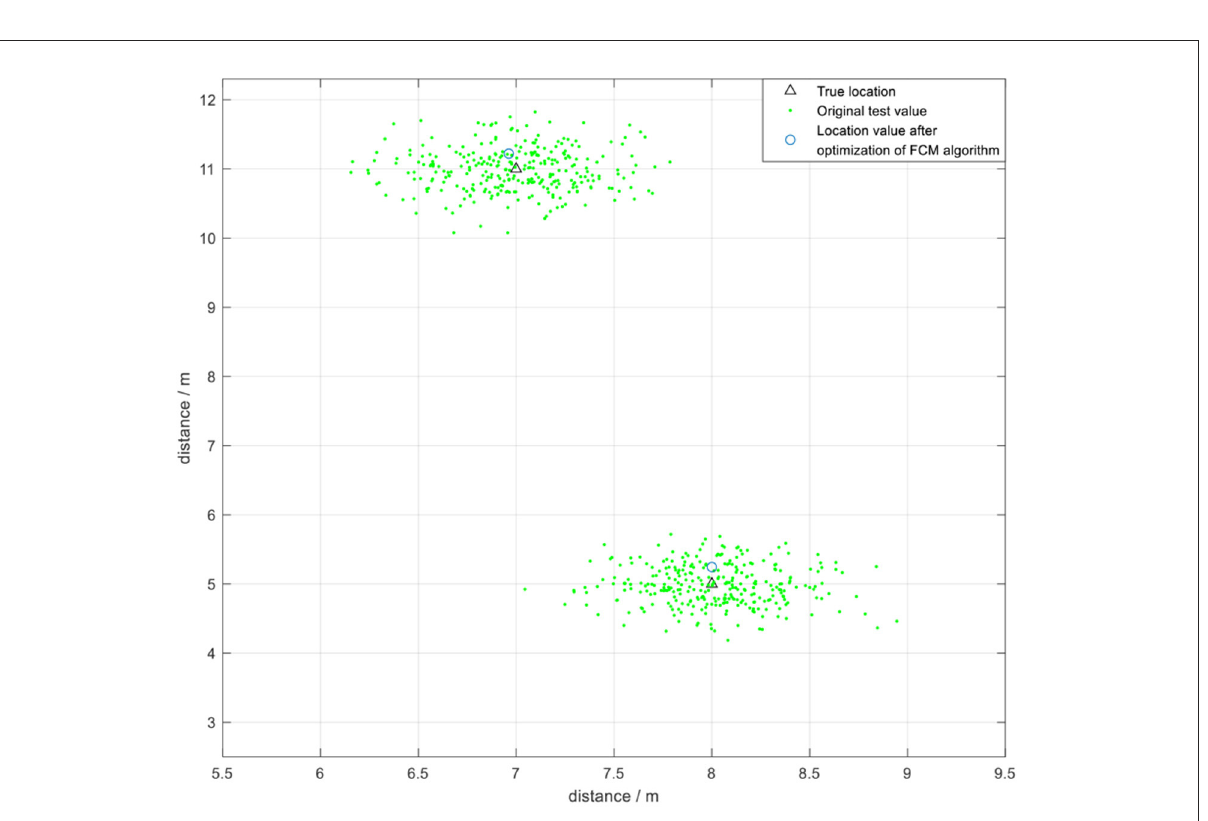
FIGURE16 The positioning effect under FCM algorithm without optimization.